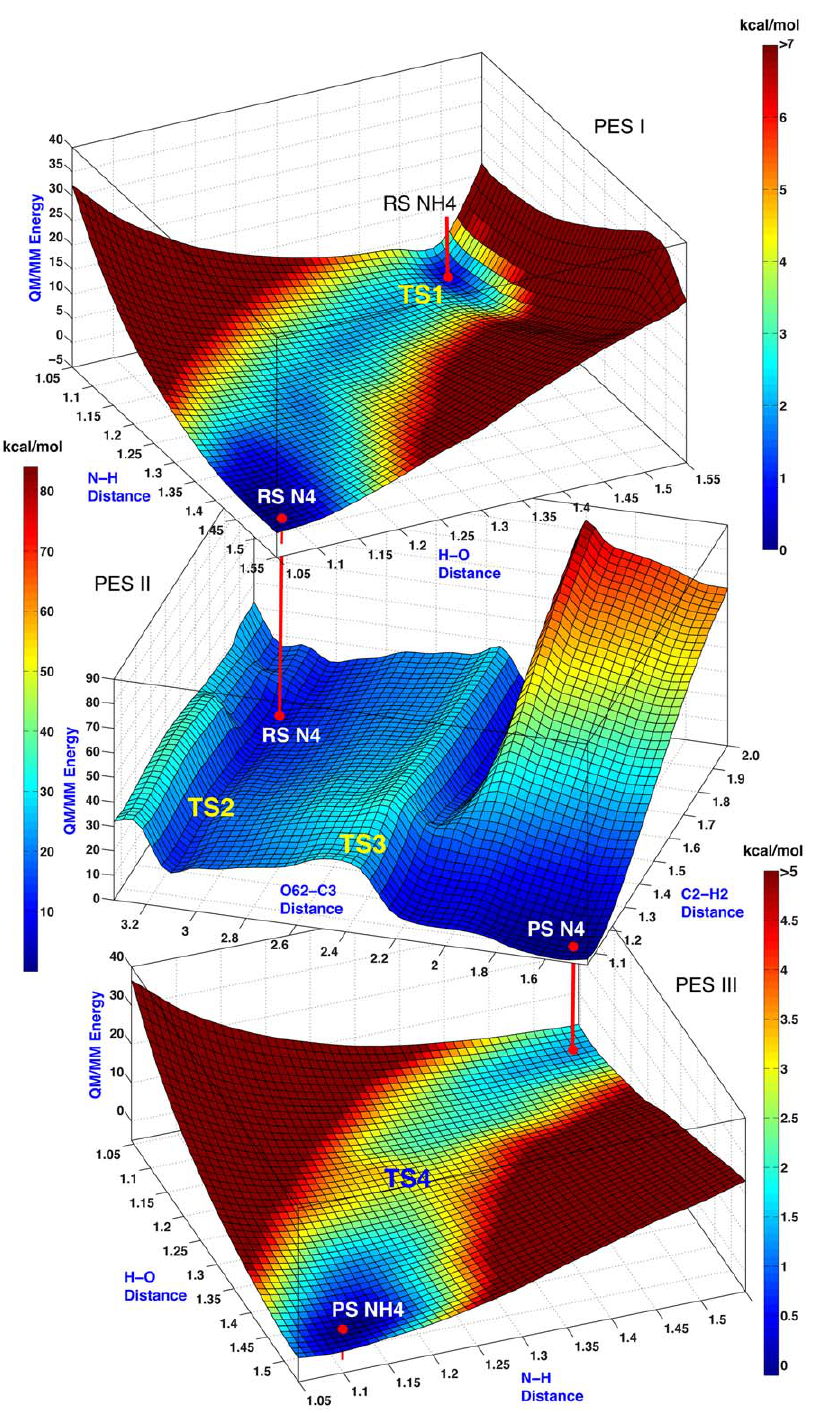
Figure 5. PESs of the non-enzymatic formation of the bicyclic derivative of biapenem when N4 is deprotonated. The reaction path corresponding to the red trace in Fig. 4 spans three separate PESs: red vertical lines connect the equivalent phase-space points of each PES (the jump points from one PES to another). PES I corresponds to a proton transfer (TS1) from N4 of hydrolyzed biapenem to a hydroxide ion. PES II corresponds to the proton transfer from the hydroxyl oxygen to C2 (TS2) and the formation of the C3–O bond (closure of the 6-membered ring, TS3). PES III corresponds to the reprotonation of N4 from water (TS4). QM/MM energies are in kcal/mol. Colors on the PESs reflect the QM/MM energy levels, as represented in the reference bars on the side of each PES.